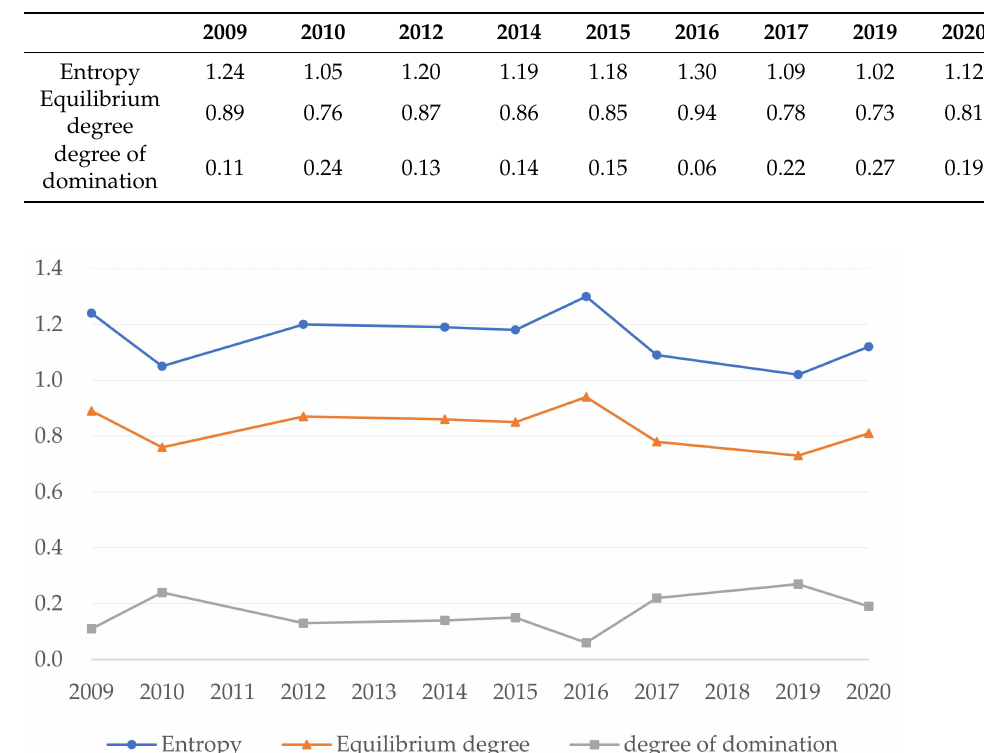
Figure 7. The change of information entropy, equilibrium degree, and dominance degree of land